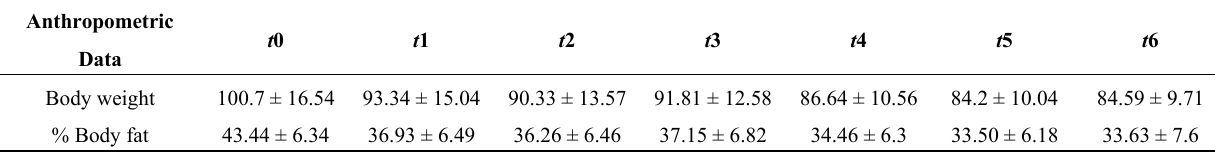
Table 2. Changes in body weight and body fat percentage during one year diet protocol. Values are expressed as mean and standard deviation. Significance was reported in Results